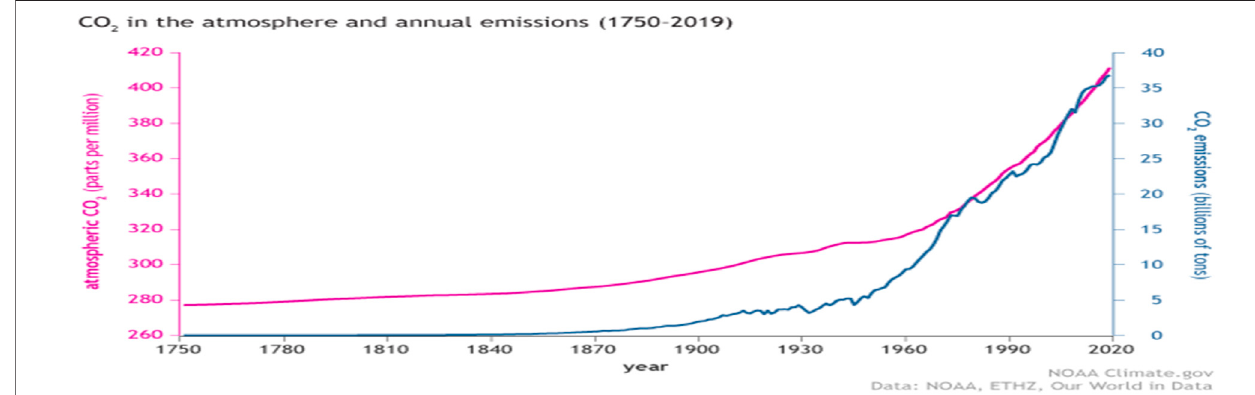
FIGURE 1 | Concentration of carbon dioxide emissions between the year 1750 and 2020 (Lidsey,